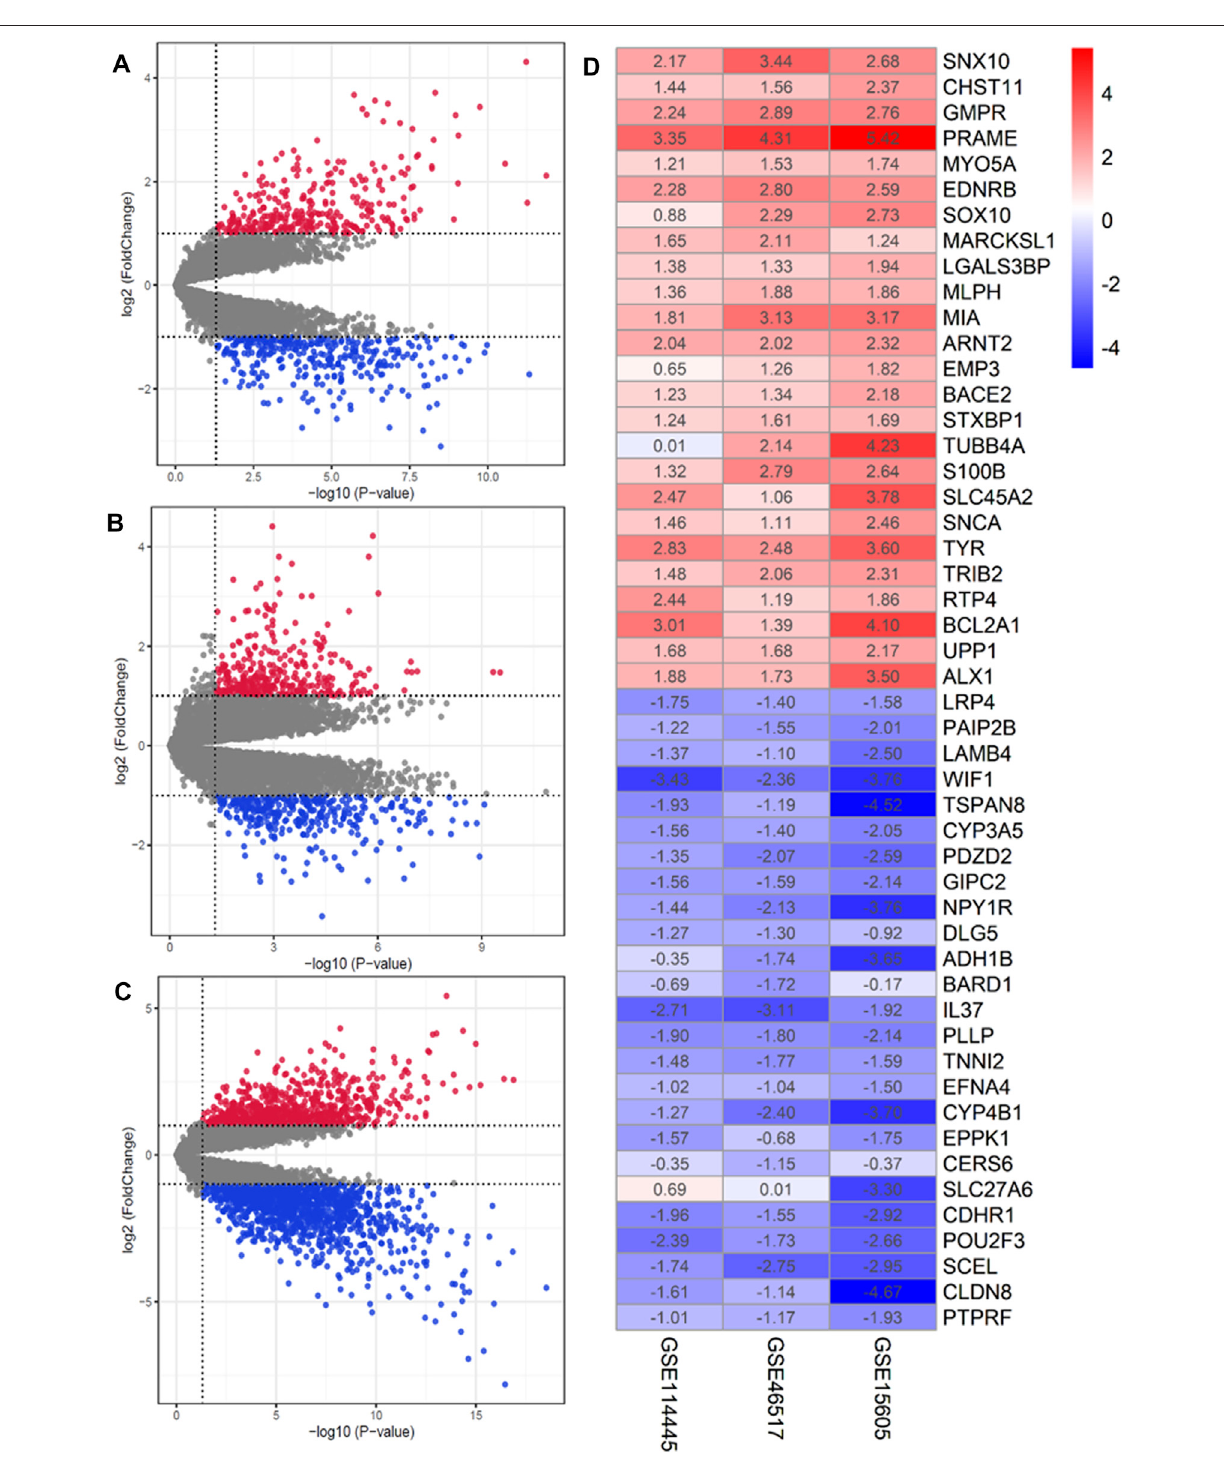
Frontiers in Cell and Developmental Biology |